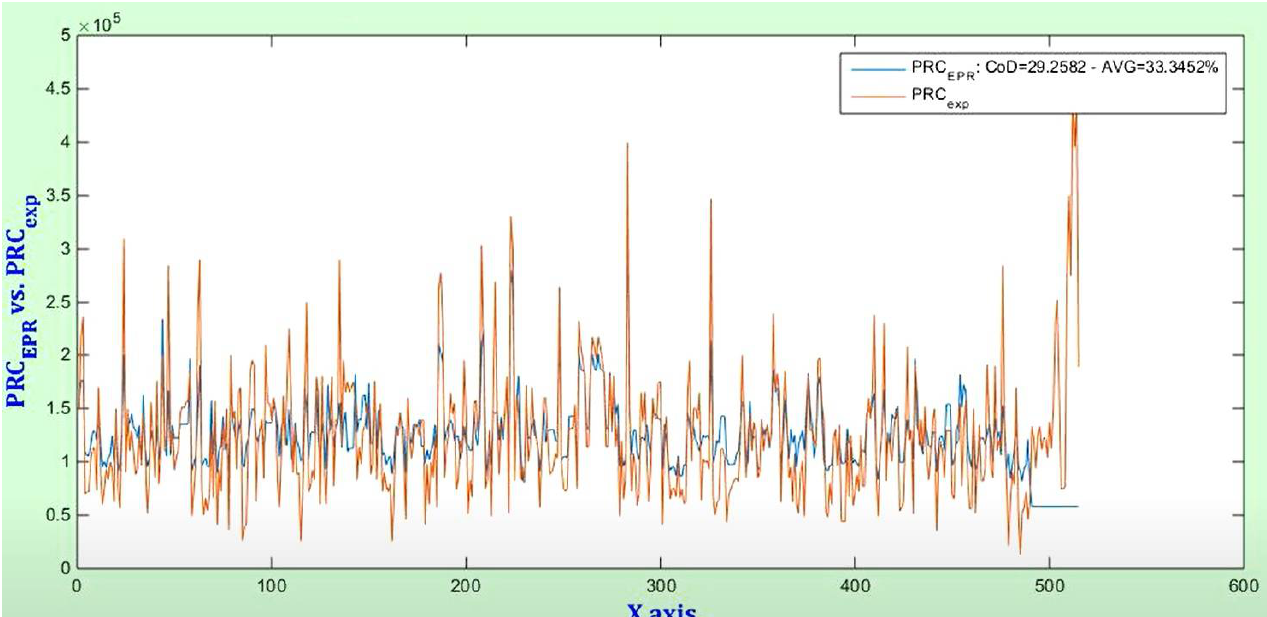
Figure 1. Selling price determined by EPR-MOGA (PRC EPR ) vs. selling price expected for model I (PRC exp ).